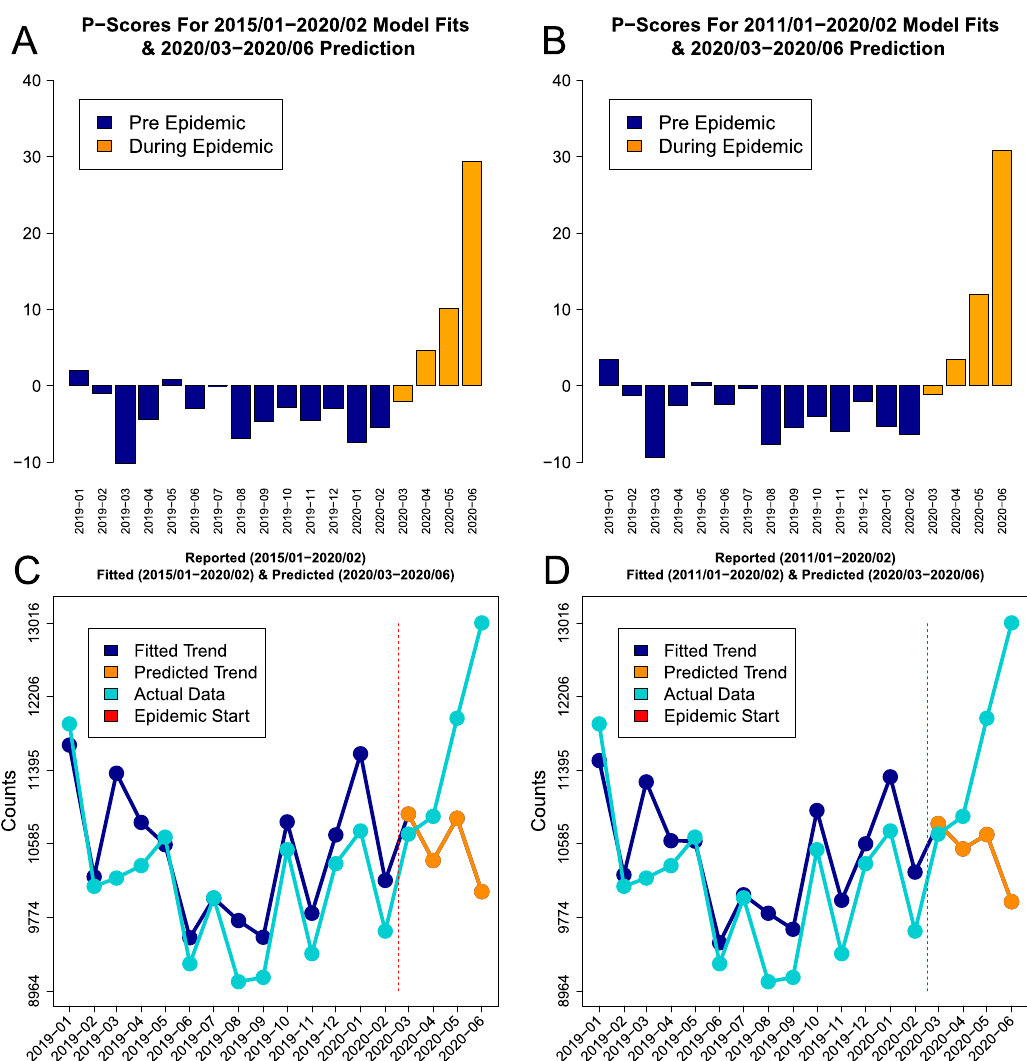
Figure 5. The visual summaries of parametric mortality P -scores based on the Prophet model without demographic characteristics are presented for five (panel A ) and nine (panel B ). The orange bars represent the epidemic period. The corresponding Prophet model predictions (dark blue) based on the previous five (panel C ) and nine (panel D ) years are presented along the reported data (cyan). Vertical red bars indicate the epidemic start